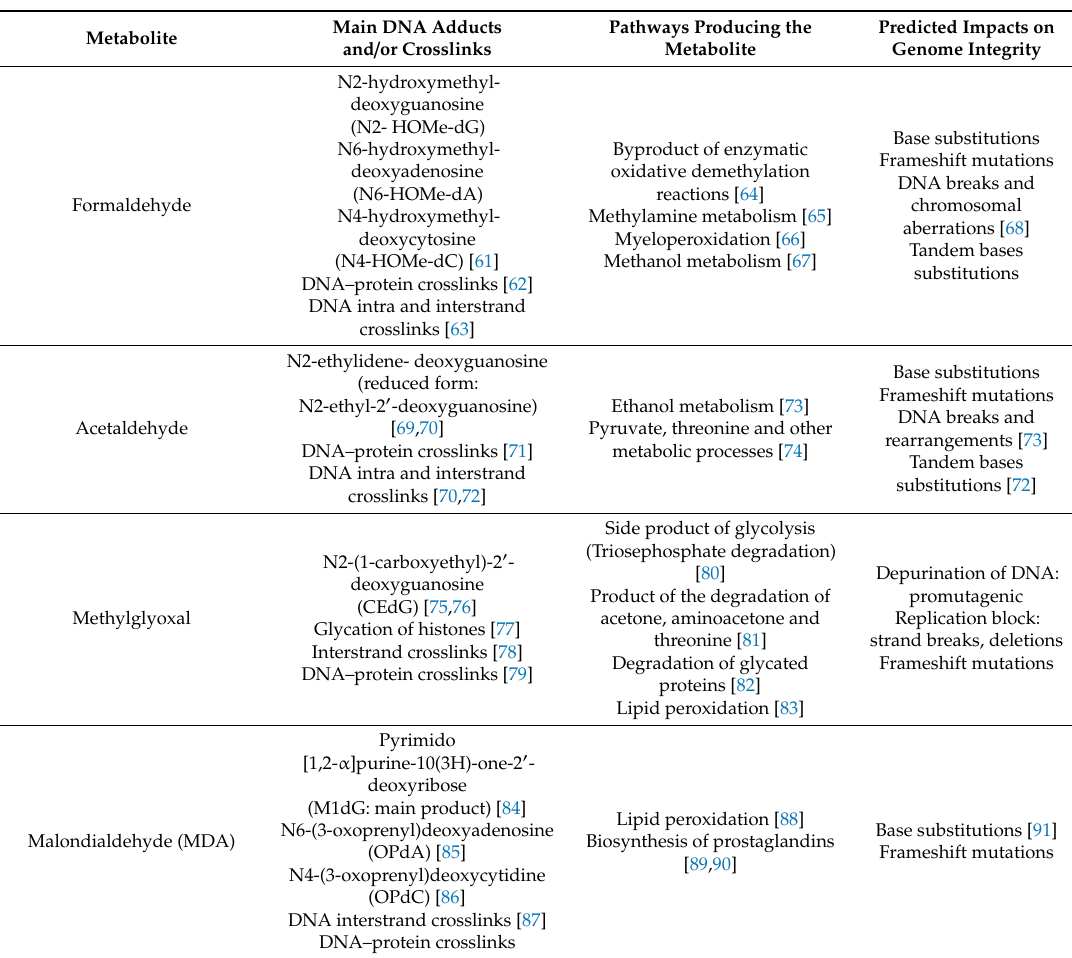
Table 1. Endogenous metabolites generate mutagenic DNA adducts. This table indicates the most studied endogenous aldehydes and alkylating agents that generate DNA adducts, summarizing the types of adducts that are created, the endogenous pathways producing these metabolites, and the long-term consequences of the adducts on genome integrity. A detailed overview of the di ff erent mutations and impacts on genome instability of these metabolites can be found in more focused reviews